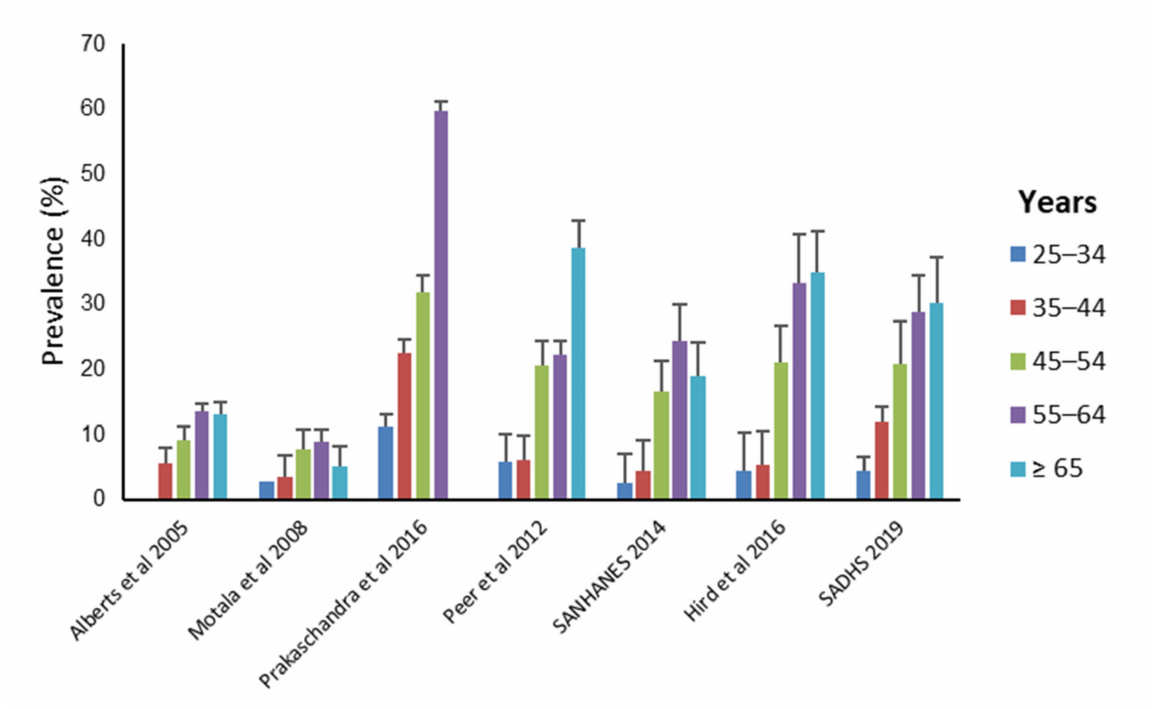
Figure 4. T2DM prevalence across age